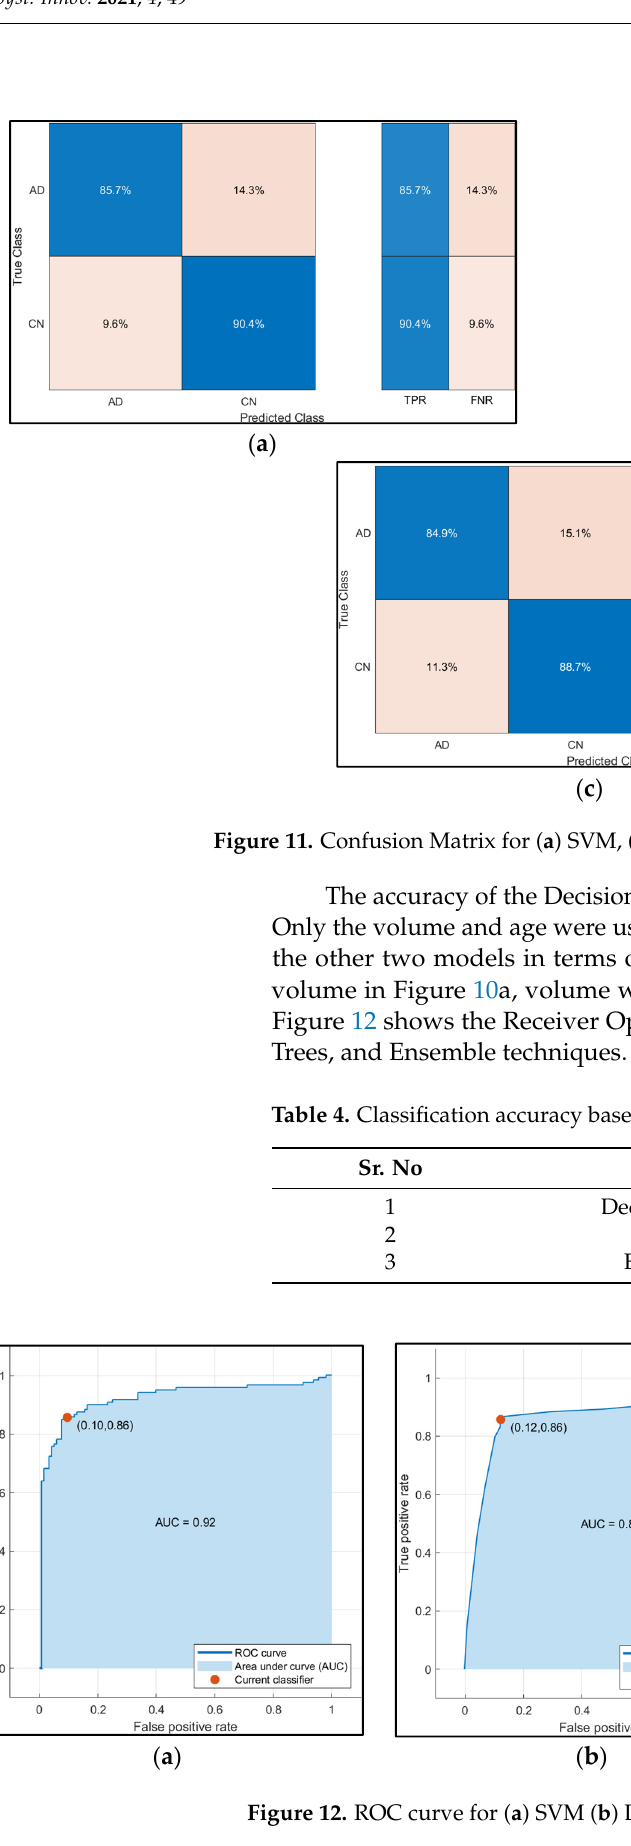
Figure 10. Scatter–plot representation of the GLCM features (AD-Blue, CN-Orange): ( a ) Age vs Hippocampus Volume; ( b ) Autocorrelation vs Correlation; ( c ) Entropy vs Energy; ( d ) Homogeneity vs Maximum Probability; ( e ) Information measures of correlation 1 and 2.